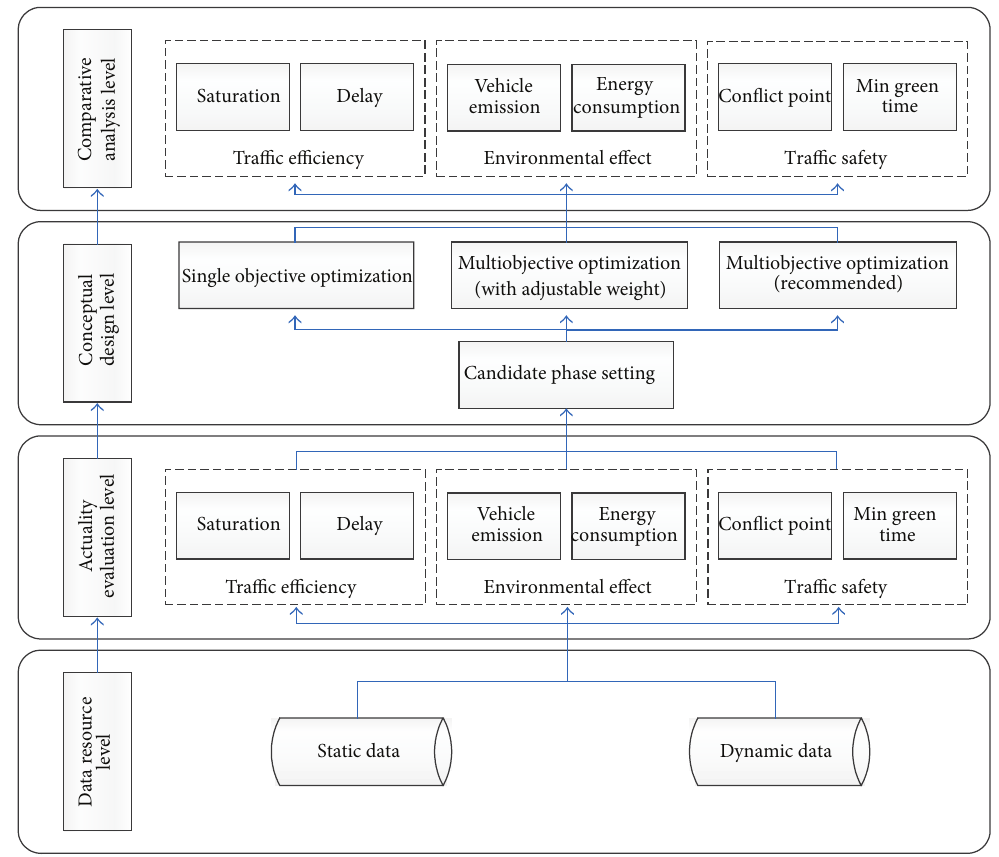
Figure 2: Architecture of automation countermeasure